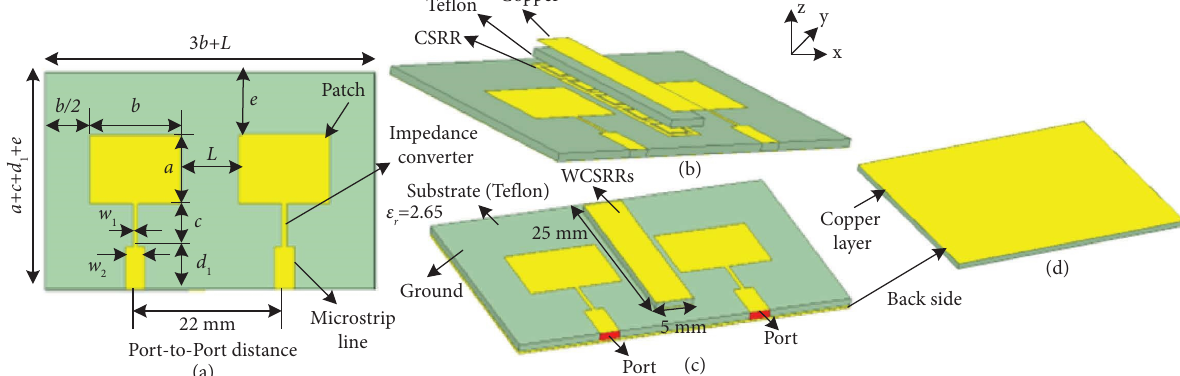
Figure 1: Schematic of the proposed microstrip antenna array. (a) Layout of the reference microstrip antenna array. (b) Compositional structure. (c) Proposed antenna array with WCSRRs. (d) Backside of the proposed antenna array.